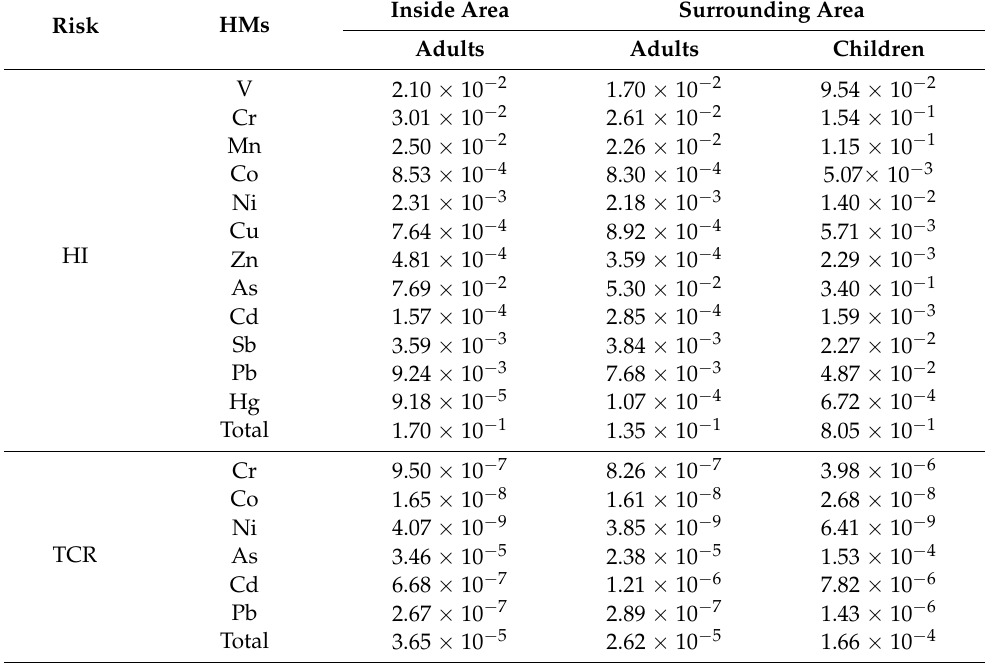
Table 2. Non-carcinogenic (HI) and carcinogenic health risks (TCR) of HMs in